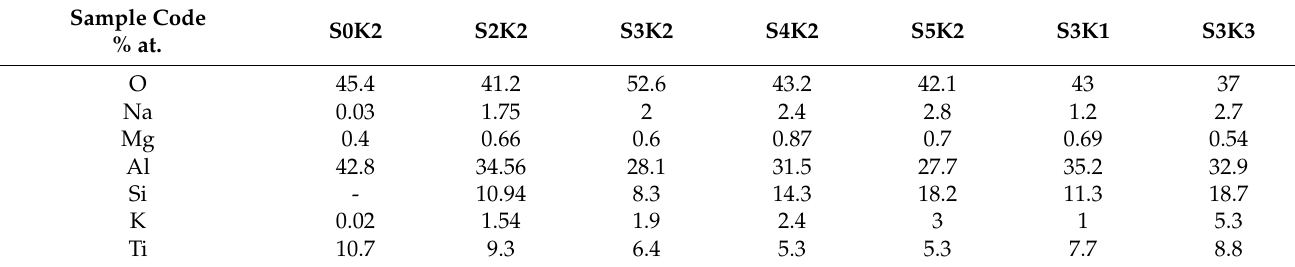
Table 2. EDS results of the PEO coatings prepared in different coating